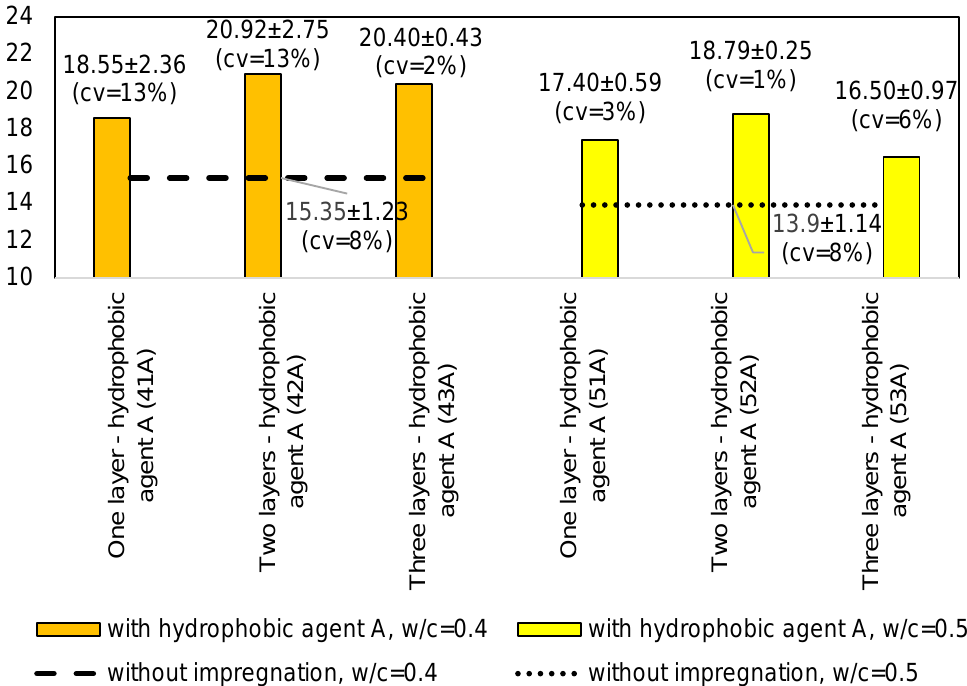
Figure 6. Rebound number comparison for samples with different w/c and impregnation using hydrophobic agent B.